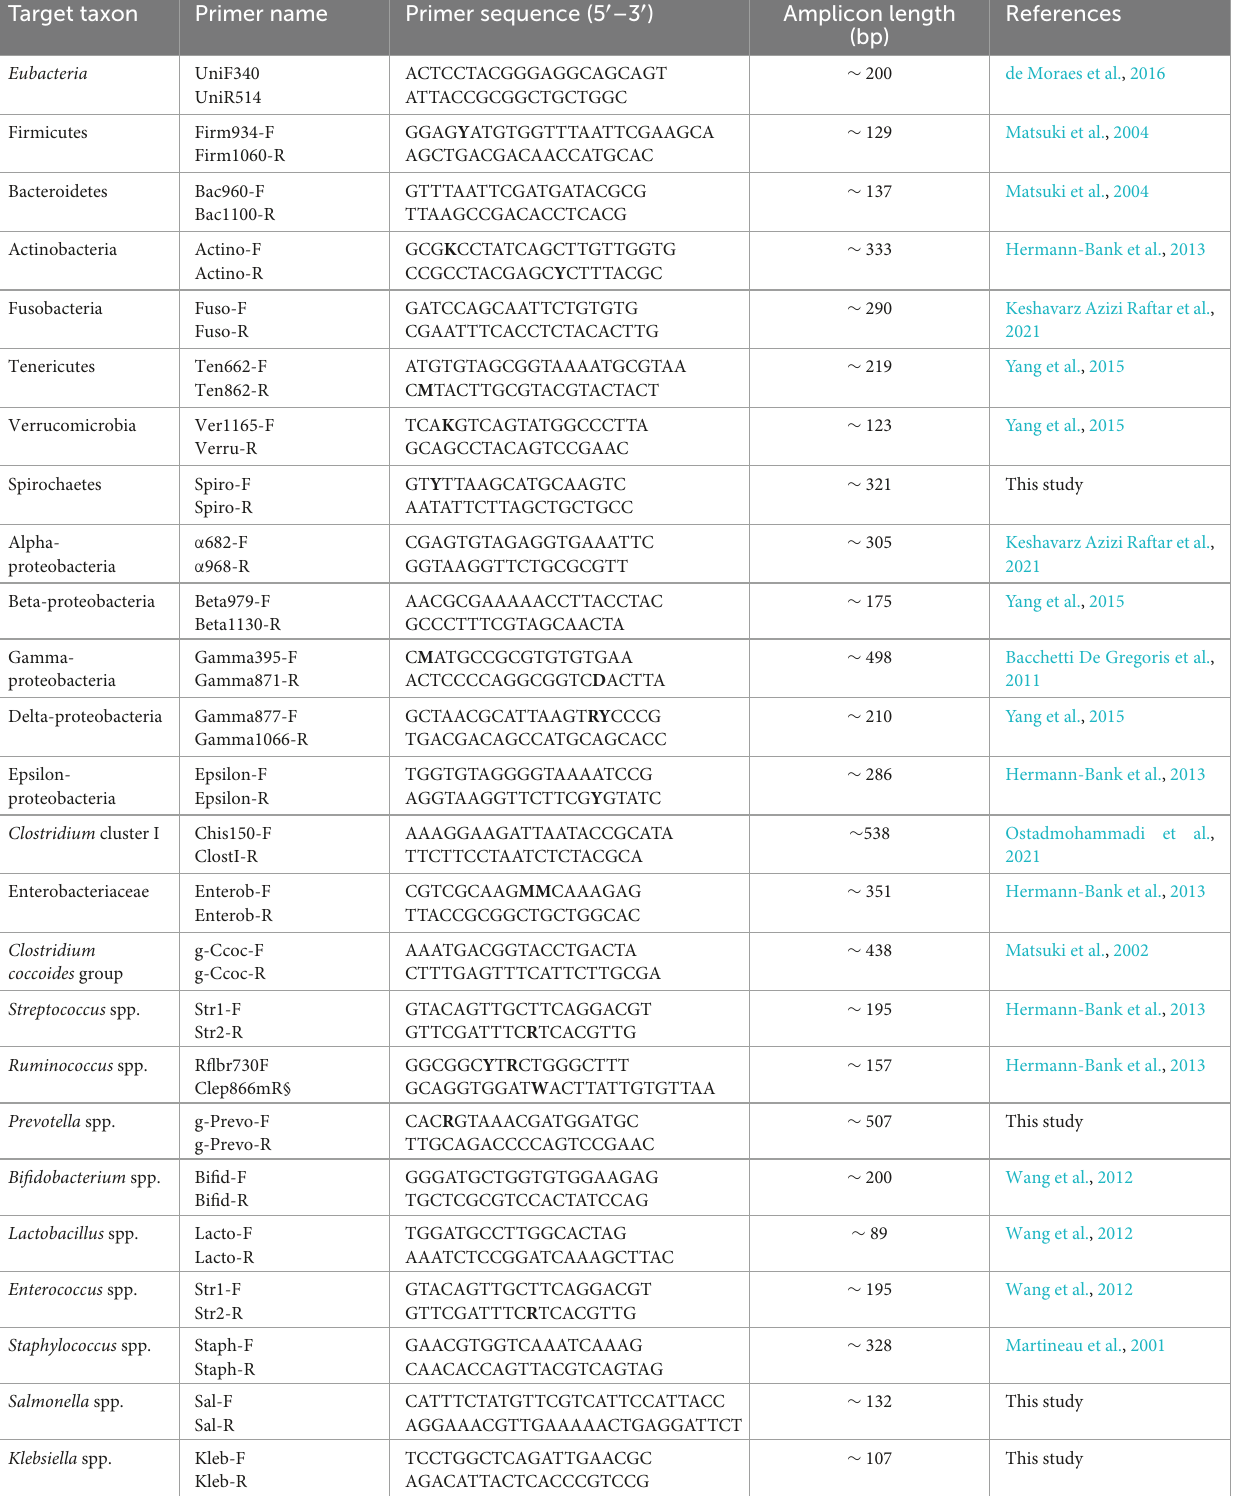
TABLE 1 The gut microbiota taxon-specific primers used in this